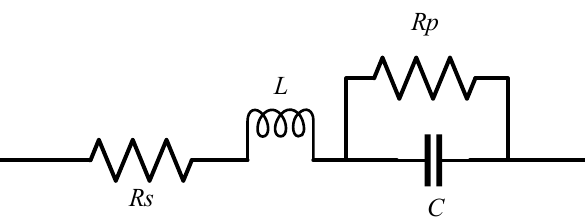
Figure 7. First order circuit model of DLCs, which can be described as a variation of the classical equivalent circuit model, taking into account the inductance of the capacitor leads and the inductance of the current paths in the capacitor.